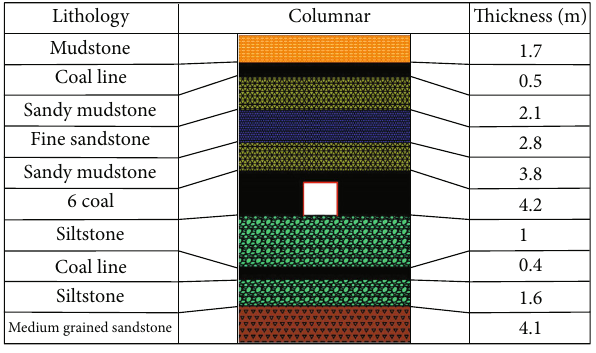
Figure 3: Synthesis column map of the surrounding rock.